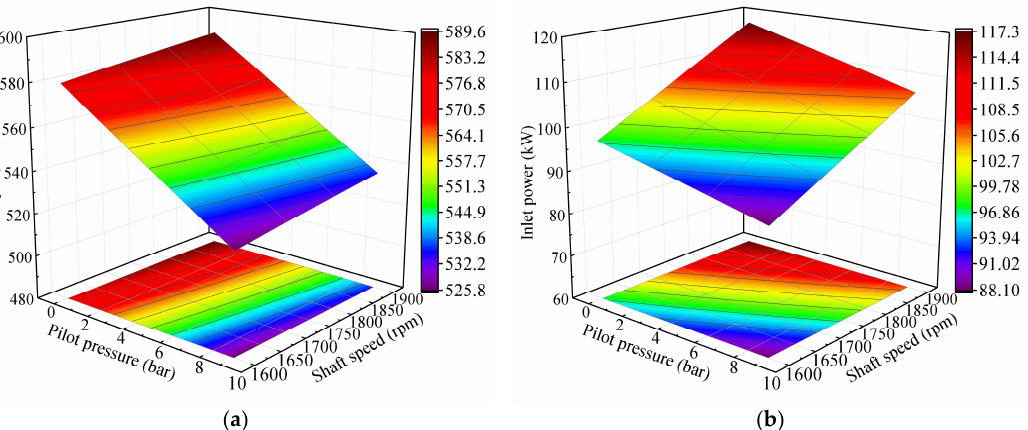
Figure 19. Spindle torque and input power of the double-compound axial piston pump: ( a ) spindle torque; ( b ) input power.